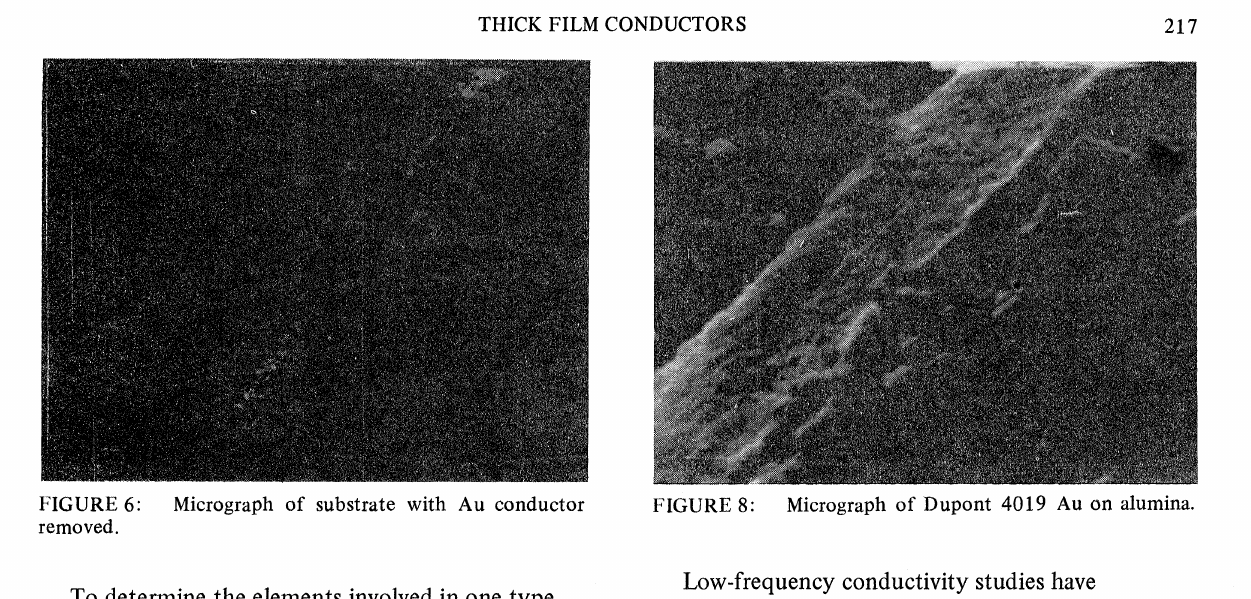
Micrograph of substrate with Au conductor removed.